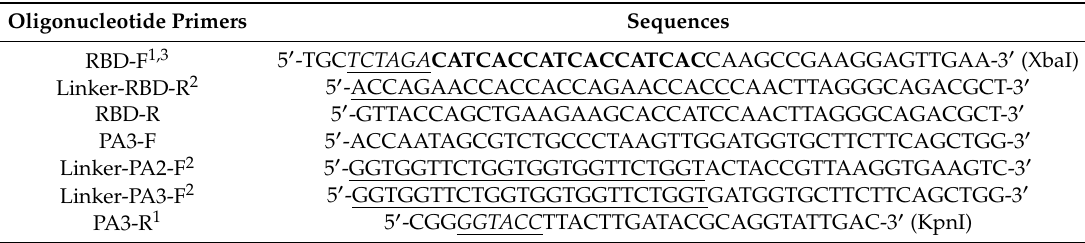
Table 1. Oligonucleotide primers used in this